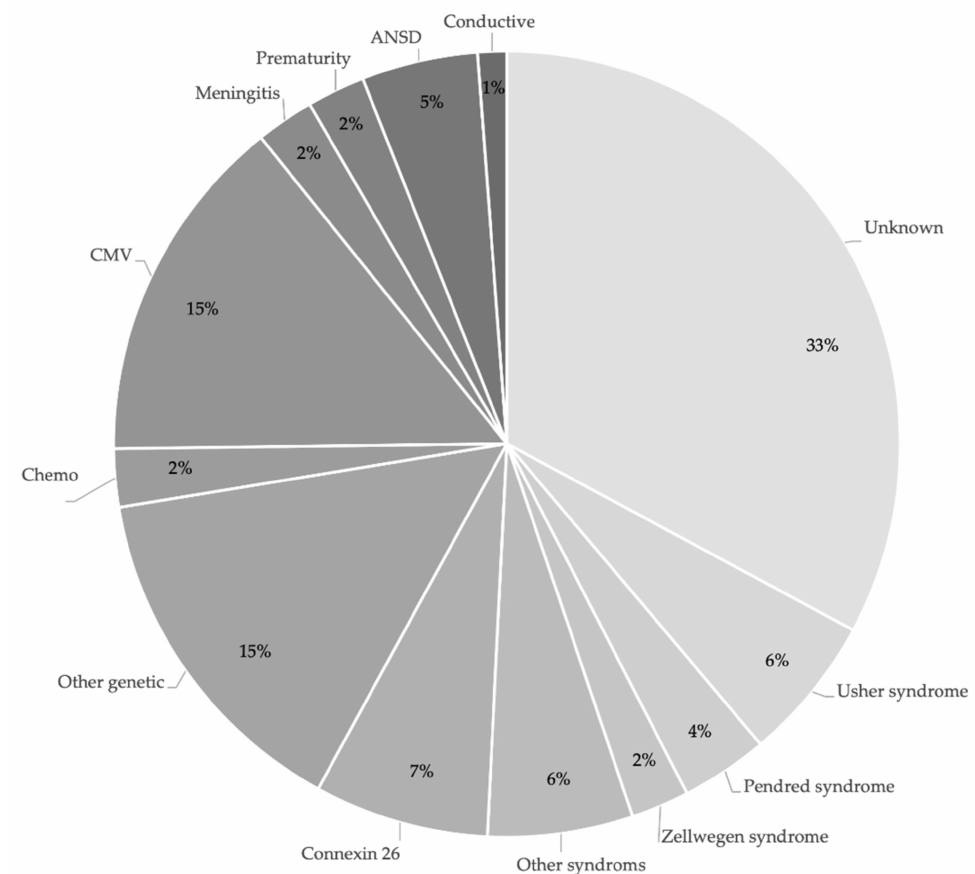
Figure 2. Etiology of hearing loss. (ANSD = Auditory Neuropathy Spectrum Disorder/CMV =